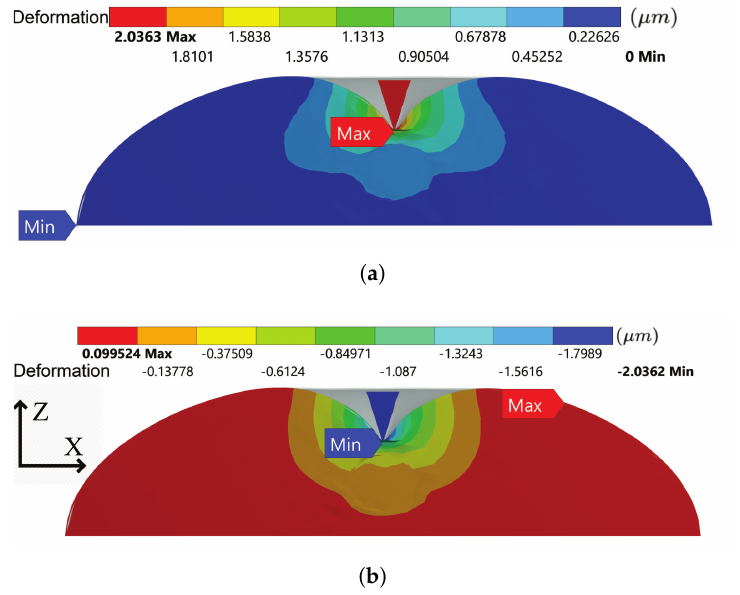
Figure 7. The deformation of the hyperelastic components in the representative cross section when indentation distance reaches 2µm: ( a ) total deformation ( b ) Z-axis